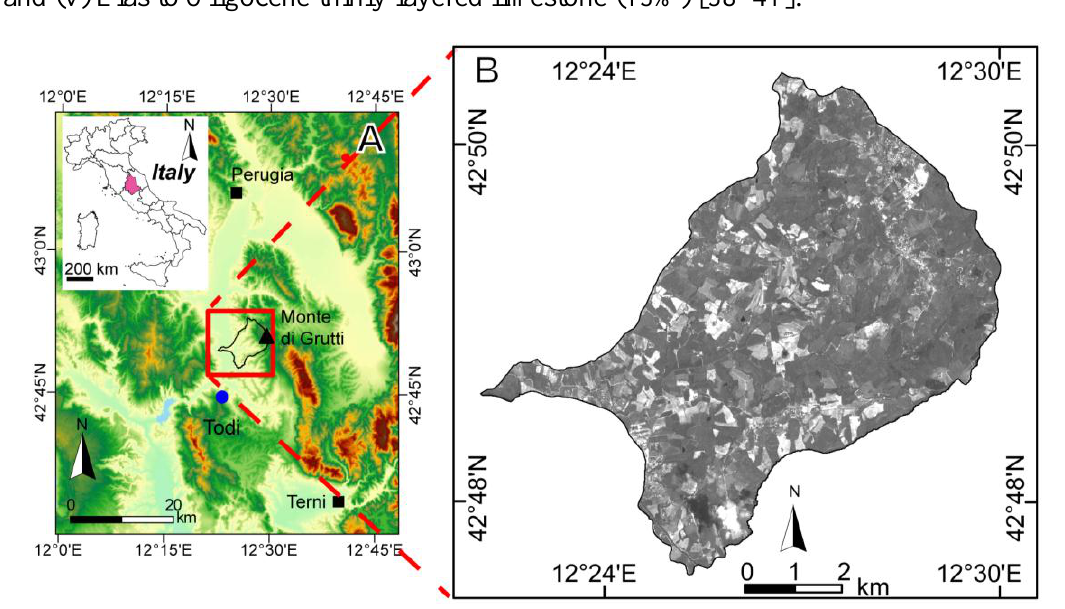
Figure 1. Location map. ( A ) The Umbria Region is in pink (inset), and the shaded relief map shows the location of the study area (DEM 20 meter resolution obtained from interpolation of counter lines). The blue dot represents the Todi rain gauge. ( B ) GeoEye-1 ® image taken on 27 May